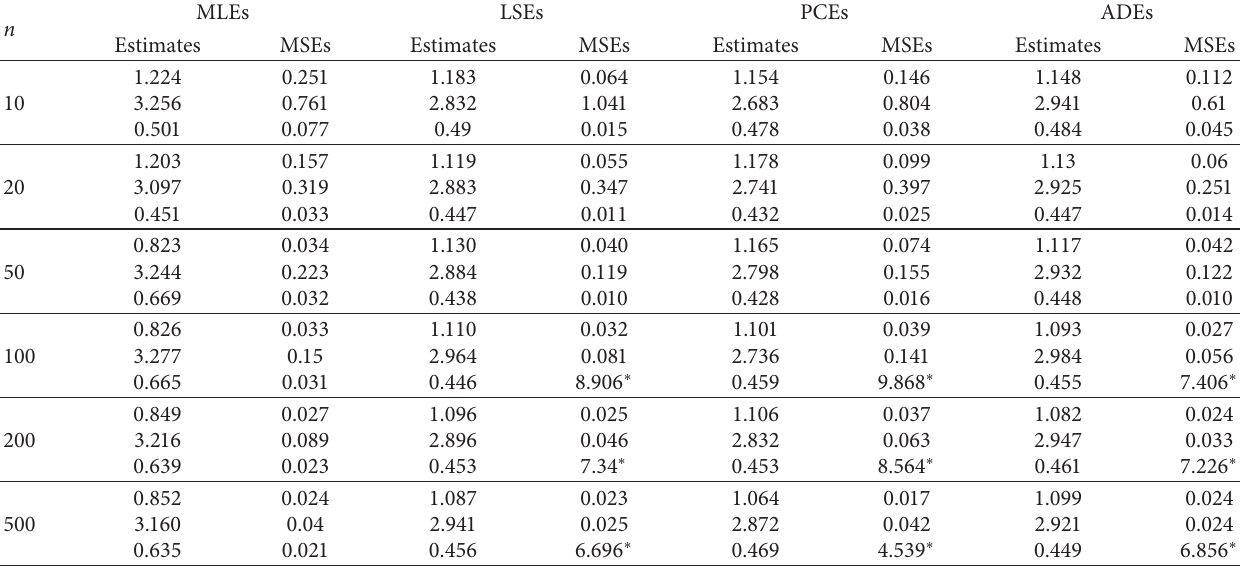
Table 4: Estimates and MSEs of the OFIL distribution for MLEs, LSEs, PCEs, and ADEs for set 3 ( α � 1 , θ � 3 , and β � 0 . 5). MLEs n